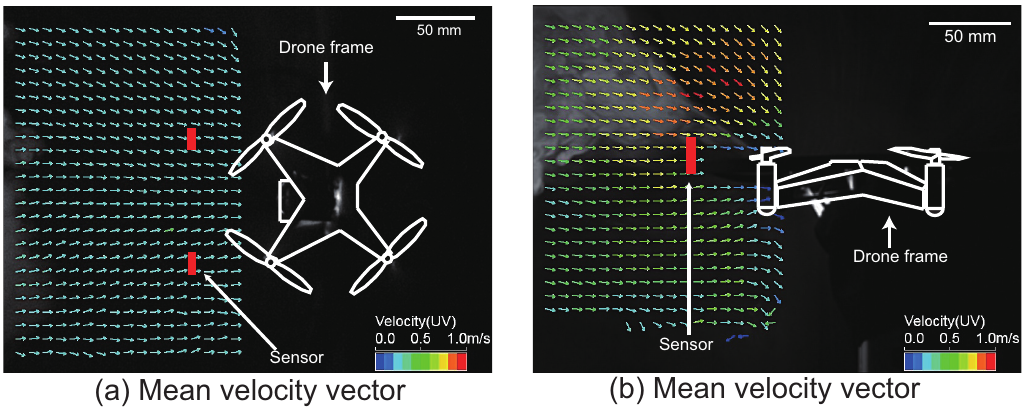
Figure 7. Quadcopter top and lateral view of the air velocity vector by the PIV measurement. The direction of the arrow represents the direction of the airflow, and the difference in color represents the speed. The PIV image corresponds to the average vector per